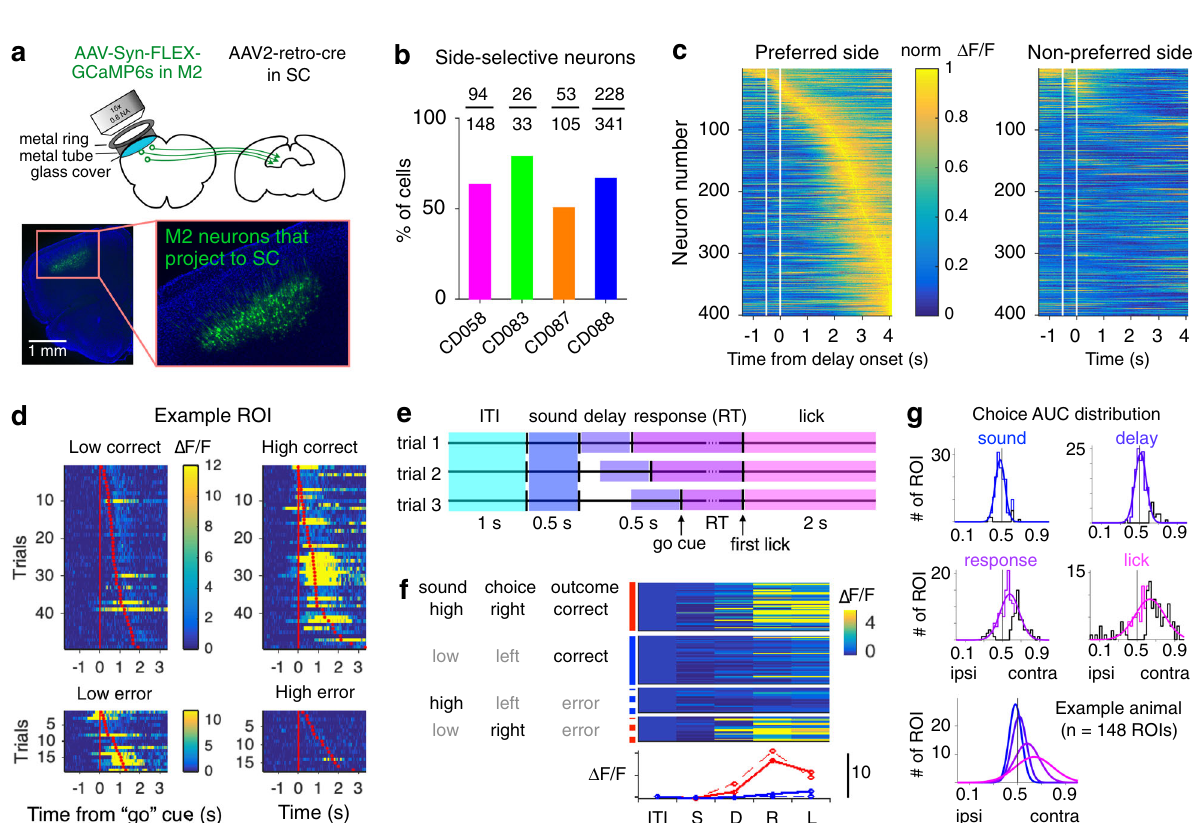
Fig. 3 Projection-based imaging reveals choice-related information in the M2-SC pathway. a Design for projection-based imaging experiments (top) and example histology that shows the selective expression of GCaMP6s in SC-projecting M2 neurons (bottom). b Percentage and the actual number of side- selective neurons for different animals. c Dynamics of all side-selective neurons separated by the choice of the animals, sorted by the time of peak activity on the preferred side. White lines mark the timing of the sound period. d Responses ( Δ F/F) of an example choice-selective ROI from one imaging session. Each row shows the response for one trial. Red ticks mark RT across trials. Each of the four panels shows one trial type. Diagonal panels correspond to the same type of choice. e Schematic that shows the relevant time window of responses extracted for different behavioral epochs. f Simpli fi ed response pro fi le for the same ROI as d . Top, average activity across frames in each behavioral epoch for individual trials. Each block of trials corresponds to one of the four trial types. Bottom, red and blue traces show the average Δ F/F responses for right and left trials (solid for correct, dashed for error trials) across behavioral epochs. g Histograms and Gaussian fi ts (smooth lines) to distributions of AUC values of all the ROIs from one example animal ( n = 148 ROIs), during the sound, delay, response, and lick epochs. Black lines show individually signi fi cant neurons. Right, distributions across epochs are plotted together to reveal a gradual increase of contralateral selectivity over